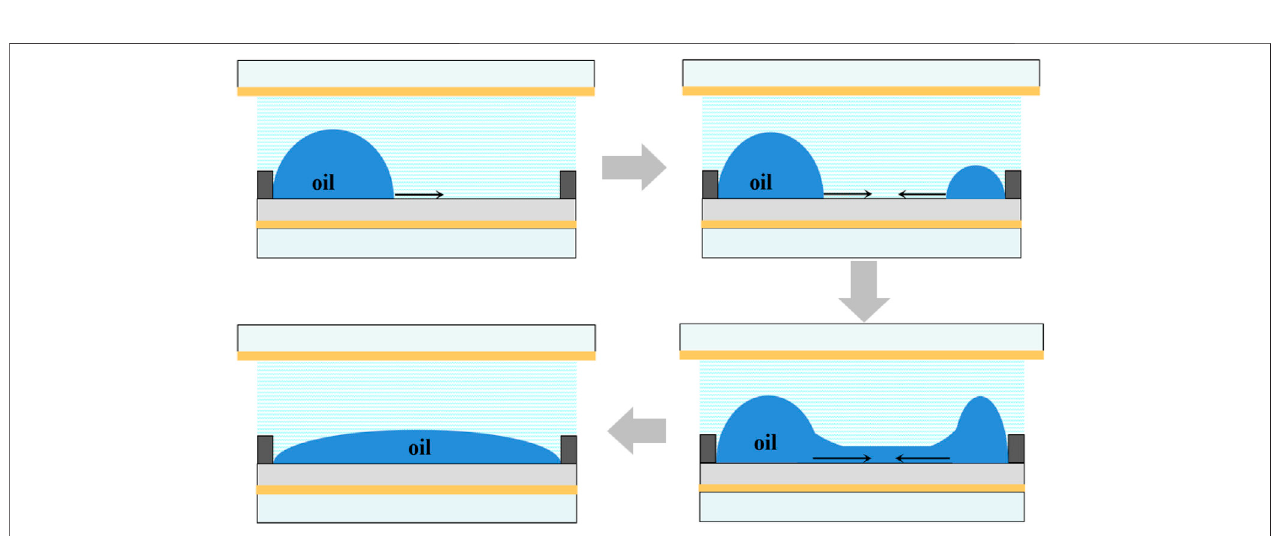
FIGURE 3 | The process of oil fi lm recombination in a pixel from on-state to off-state. For the off-switching process, when the driving voltage is decreased, the oil begins to recombine with slight fl uctuation, and the oil is spread out in the pixel gradually.